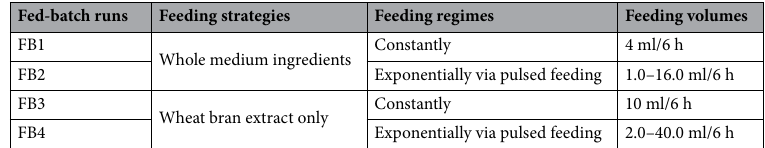
Feeding regimes Feeding